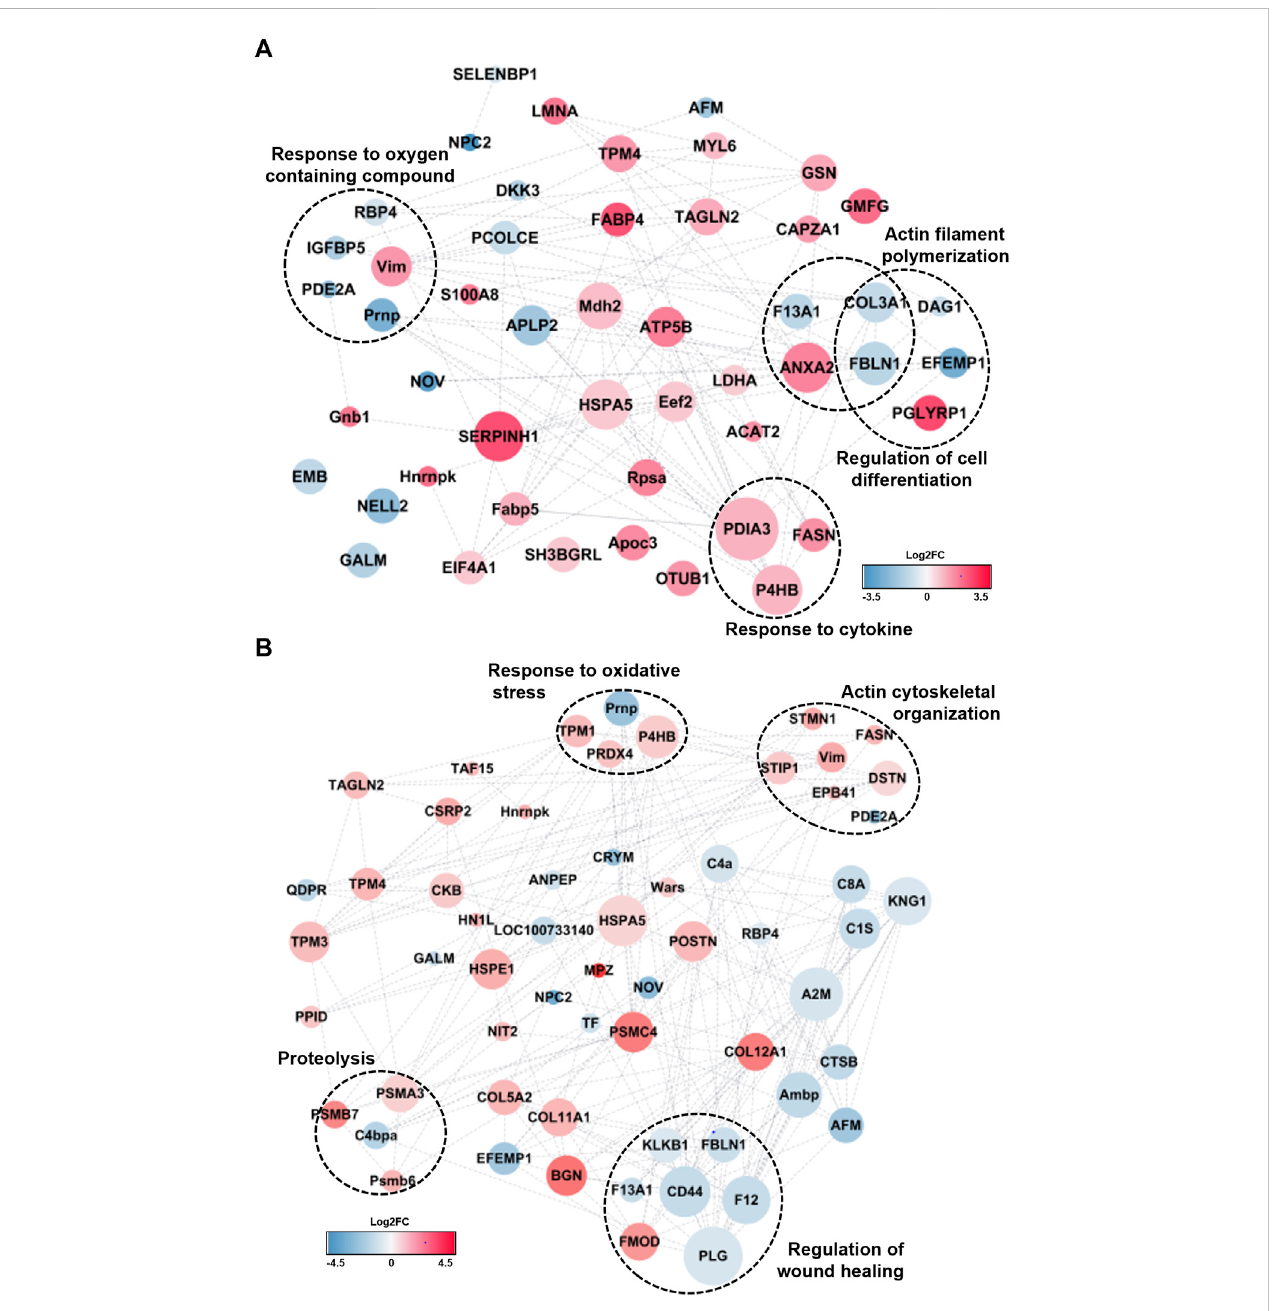
PPI analysis of DEPs after DVV treatment compared from (A) control and (B) saline group with molecular functions. The Log2FC of DEPs were represented in colorimetric scheme. The red node presented upregulated proteins after DVV treatment and blue node presented those of downregulated. The size of node exhibited the interaction score between proteins. The biological process that are equivalent from global ANOVA-test were